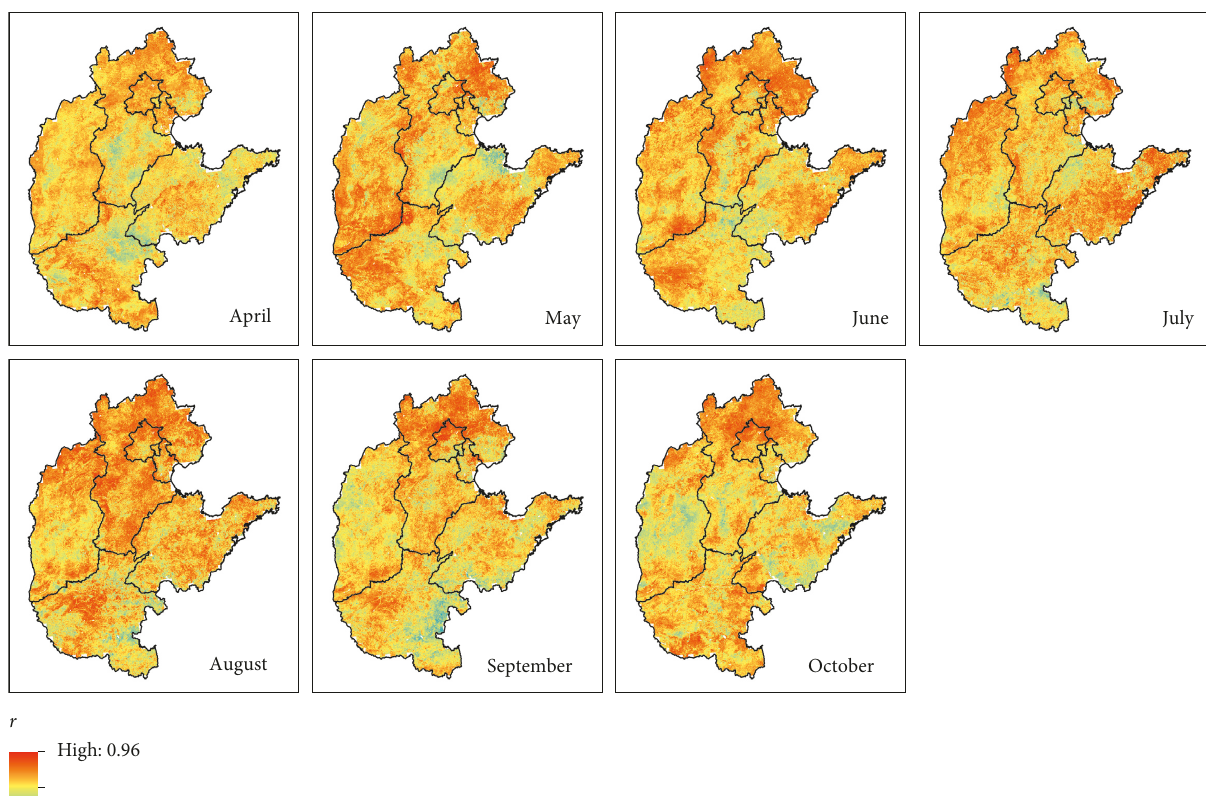
Figure 10: Spatial distribution of monthly correlation coefficients between SMAI-1 and VCI in North